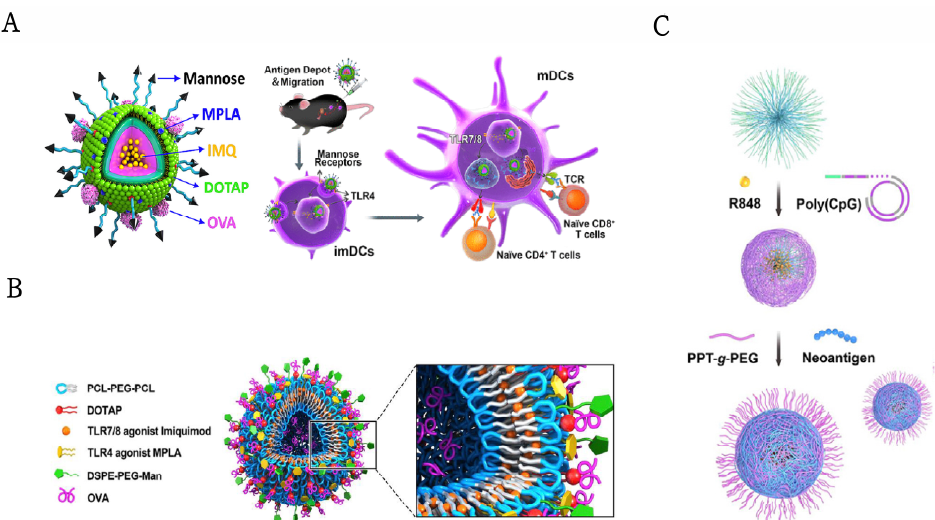
Figure 5. ( A ) Schematic illustration of the structure of MAN-OVA-IMNPs and targeted co-delivery of an antigen and dual agonists by PCL − PEG-PCL hybrid nanoparticles for cancer immunotherapy. Reprinted with permission from Ref. [43]. Copyright 2019, copyright American Chemical Society. ( B ) Schematic illustration of mannose-functionalized lipid-hybrid polymersomes (MAN-IMO-PS) for co-delivery of antigen and dual agonists. Reprinted with permission from Ref. [117]. Copyright 2019, copyright Elsevier. ( C ) Schematic depiction of the development of banNVs, which were self-assembled in three steps to potentiate neoantigen immunogenicity for personalized